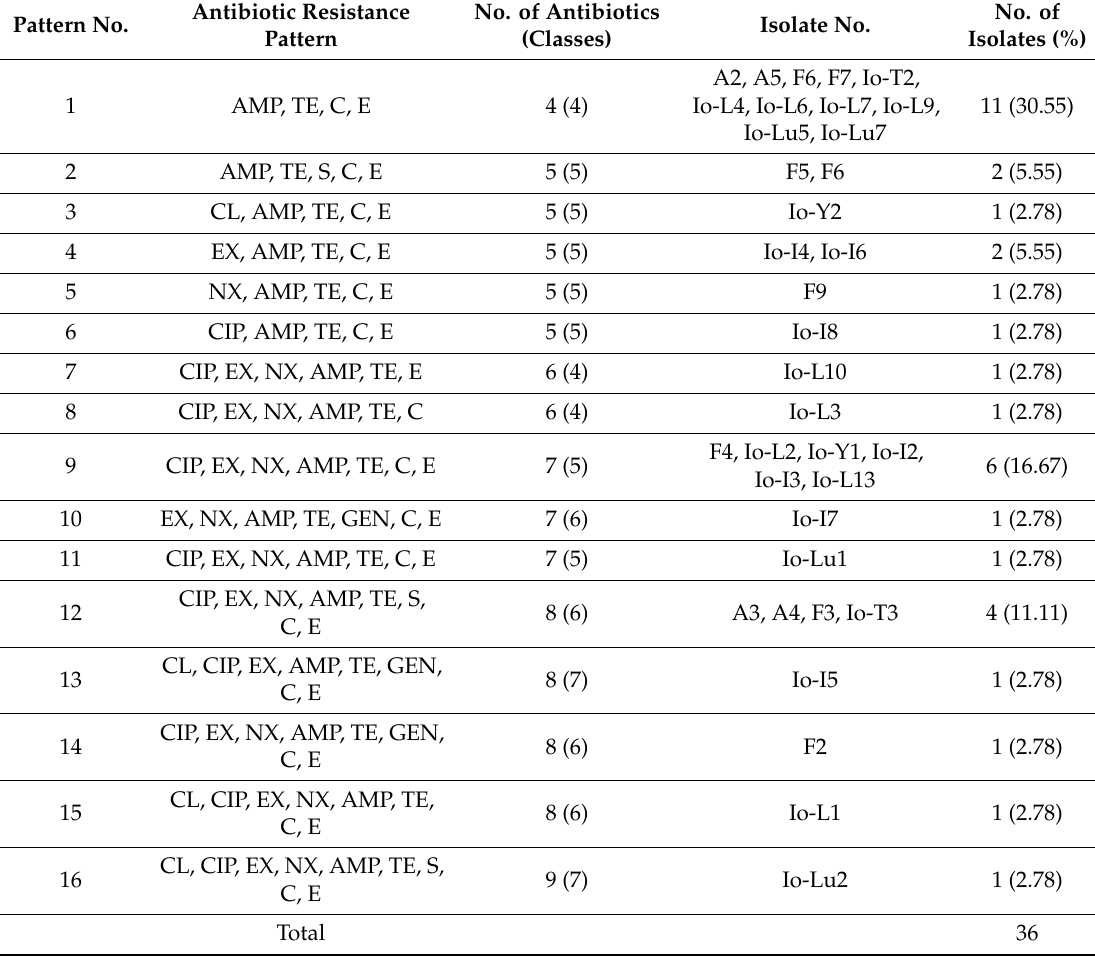
Figure 2. Sample wise antibiotic resistance profile of the isolated APEC. CL, Colistin; CIP, Ciprofloxacin; EX, Enrofloxacin; NX, Norfloxacin; AMP, Ampicillin; TE, Tetracycline; S, Streptomycin; GEN, Gentamicin; C, Chloramphenicol; E, Erythromycin. Table 5. Multidrug resistance profile of the isolated APEC.